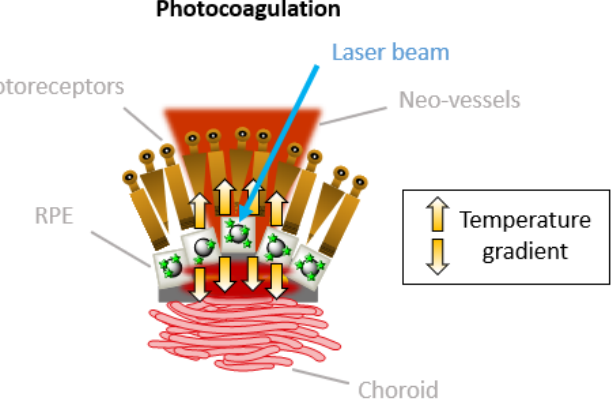
Figure 18. Laser photocoagulation mode of action.